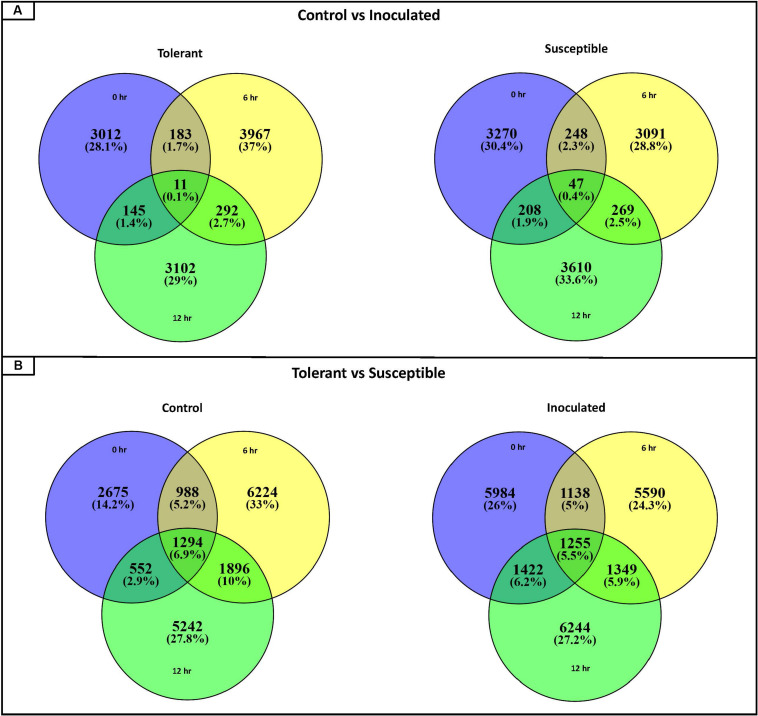
Venn diagrams representing the number of DECs (Differentially Expressed Contigs) for the 12 pairwise comparisons. (A) Number of DECs for pairwise comparisons between control and inoculated samples collected at 0, 6, and 12-h time points for the tolerant and the susceptible genotypes. (B) Number of DECs for pairwise comparisons between the tolerant and susceptible genotypes for each time point (0, 6, and 12 h) for control and inoculated conditions.